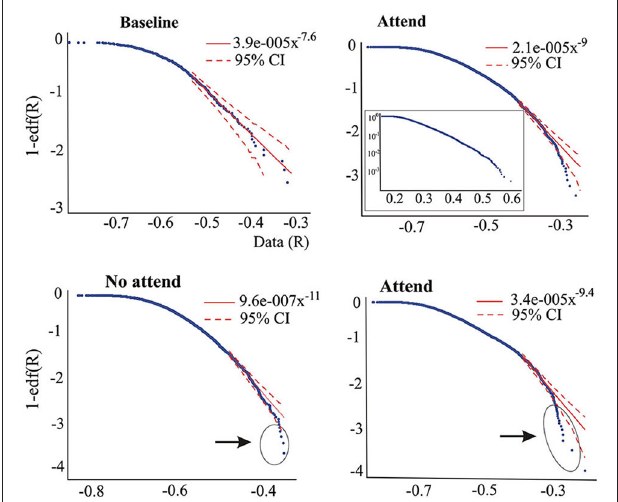
FIGURE 3 | Upper graphs correspond to one subject (ASD) performing the auditory attention task, illustrating that the tail power law characteristics disappear during the attend condition . The inset on the right-hand side graph is the log-linear plot, suggesting that the edf has more pronounced exponential characteristics rather than power law features. Lower plots are from another subject (non-ASD) showing the presence of outliers in both conditions of the auditory task, but more numerous in the “attend” condition (circled). As in Figure 2B , the middle part (70–40%) of the edf in the “Attend” condition could be fit to a power law with exponent